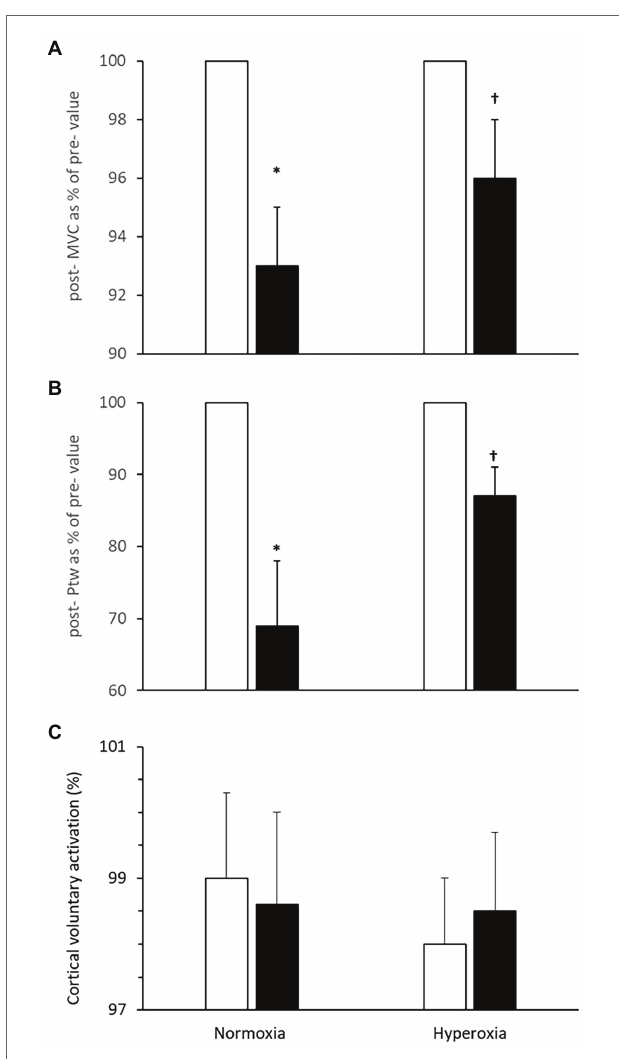
FIGURE 4 | Neuromuscular function pre- (open bars) and immediately post- (closed bars) 2,000 m all-out rowing. (A) Maximal voluntary contraction (MVC) of the arm flexor muscles; (B) potentiated twitch force ( P tw ); and (C) cortical voluntary activation. Values are means ± SD, post-values in (A,B) are expressed as % of pre-values; * Different from pre-value; †Different from respective value in normoxia ( N = 11, p <